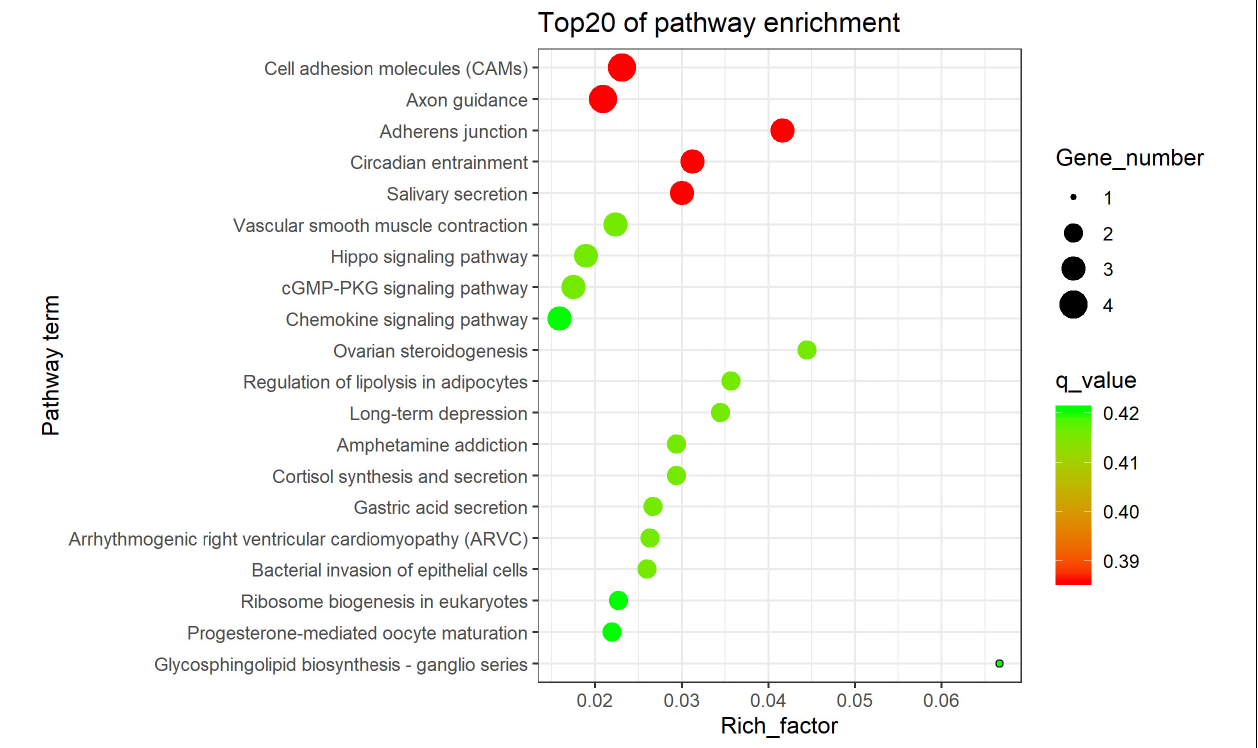
FIGURE 4 | The top 20 KEGG enrichment pathways.